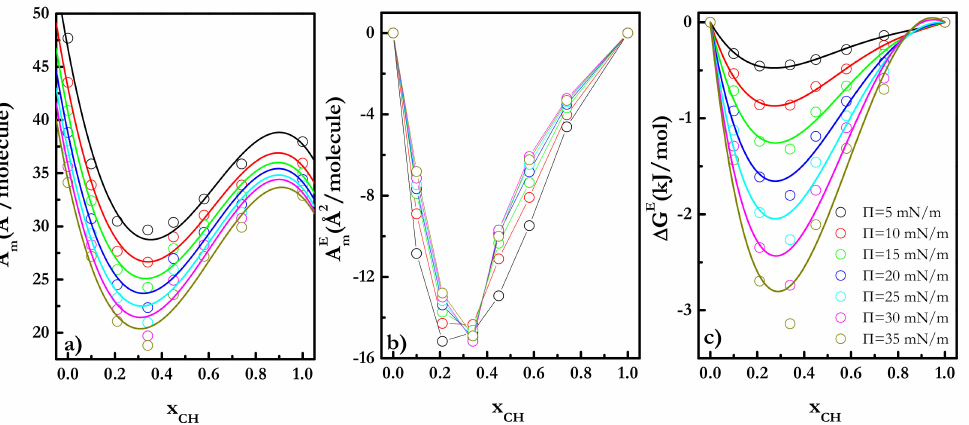
Figure 9. ( a ) Dependences of the experimental average areas per molecule on x CH for binary mixtures of CH and CS spread at the water/vapor interface at different surface pressures at 35 ◦ C. The lines are guides for the eyes. ( b ) Dependence of the average excess area per molecule on x CH for Langmuir monolayers of mixtures of CH and CE spread at the water/vapor interface at different surface pressures at 35 ◦ C. The lines are guides for the eyes. ( c ) Dependences of the excess free energy of mixing on x CH for binary mixtures of CH and CS spread at the water/vapor interface at different surface pressures at 35 ◦ C. The lines represent the fitting of the experimental data to a Redlich–Kister-type equation (Equation (9)). The color legend is the same for the three